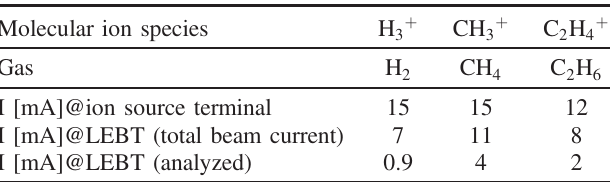
TABLE II. Beam currents achieved at 2 . 2 keV = u for various primary molecular beams.